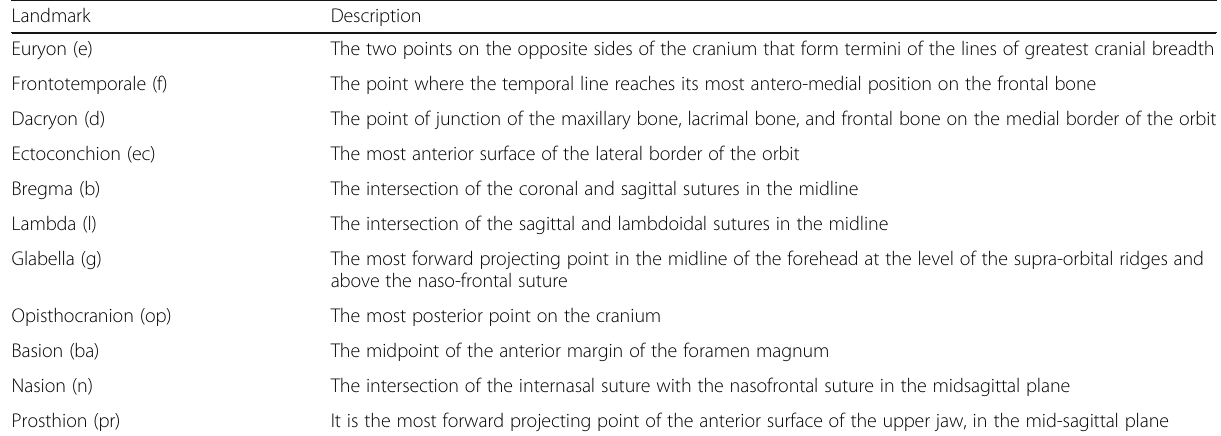
Table 1 Measurements landmarks Landmark Description